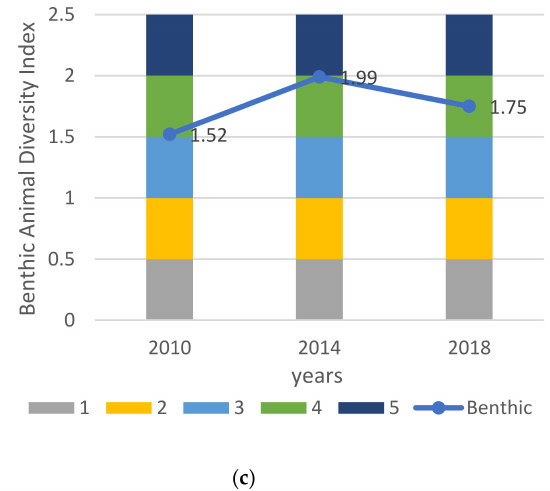
Figure 3. Assignment results of aquatic biodiversity. Note: The color in the figure represents the value range of the diversity index. If the diversity index is in the gray range, it is assigned a value of 1, and in the yellow range, it is assigned a value of 2, and so on. Light blue represents the value of 3, green represents the value of 4, and dark blue means the value is 5. The blue dots in the figure correspond to the value of the diversity index, which is connected by a line to show the change trend in the diversity index and assignment.